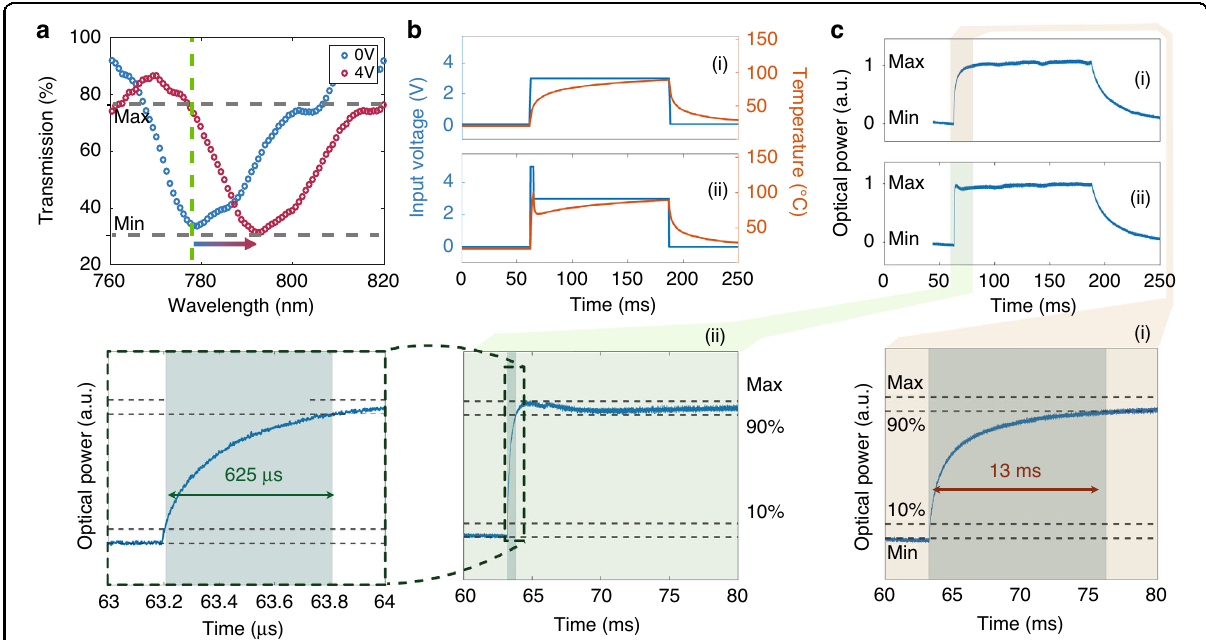
Fig. 2 Performance of the tuning method. a Metasurface transmission spectra upon applying 4 V to its contact. b Simulation of ITO strip temperature rise by a square (i), or a modi fi ed asymmetrically descending step signal (ii). c Transmission optical power from a metasurface when a voltage is applied via (i) or (ii) manner. Magni fi ed plots show the rise time under both bias pro fi les (i and ii) at the